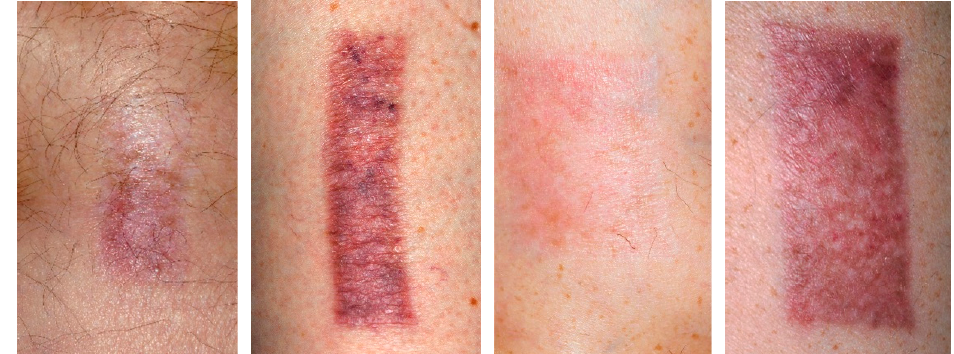
Figure 3. Four different skin graft wounds from four different patients, showing an intra-individual comparison of TBG-treatment (upper half) and standard of care (lower half) for four different results of scar formation [27].